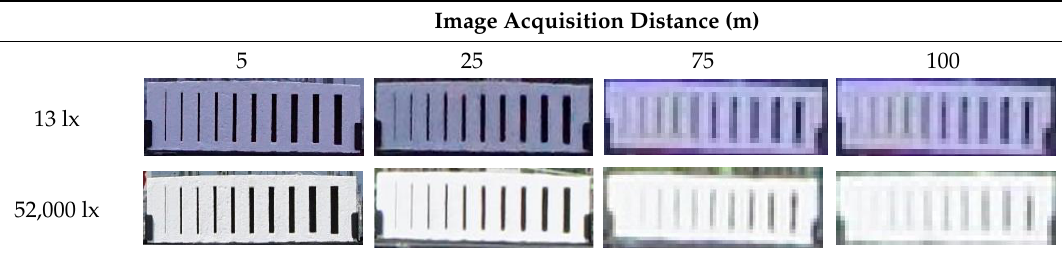
Table 3. Crack specimen images acquired by varying the image acquisition distance at 13 lx and 52,000 lx illuminations.